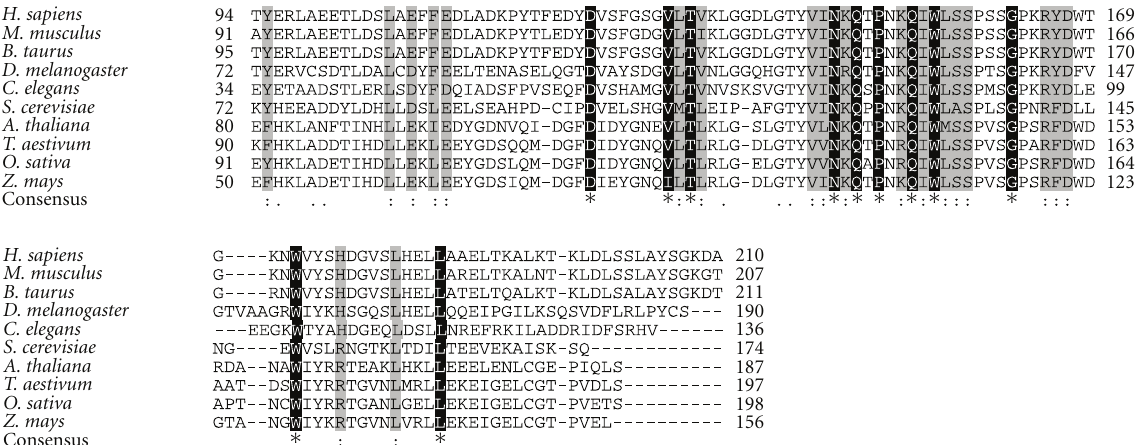
Figure 1: Sequence alignment of frataxin homologues from di ff erent organisms. The amino acid sequence of Homo sapiens (accession no. Q16595), Mus musculus (accession no. O35943), Bos taurus (accession number NP 001074196.1), Drosophila melanogaster (accession no. Q9w385), Caenorhabditis elegans (accession no. Q9TY03), Saccharomyces cerevisiae (accession no. Q07540), Arabidopsis thaliana (accession no. NP 192233.2), Triticum aestivum (accession no. CN010373), Oryza sativa , (accession no. BE040598), and Zea mays (accession no. CA830057) is shown. Alignment was performed by using the CLUSTALW2 method (Protein Weight Matrix Blosum, clustering NJ) (http://www.ebi.ac.uk/Tools/msa/clustalw2/). Identical residues ( ∗ ) are marked in black, and conserved substitutions (:) are shaded in